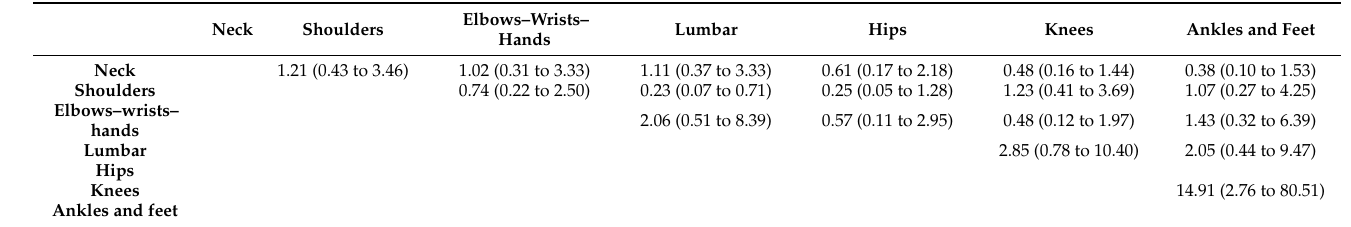
Table 4. Odds ratio (95% CI) of the associations between musculoskeletal pain in different anatomi- cal areas.